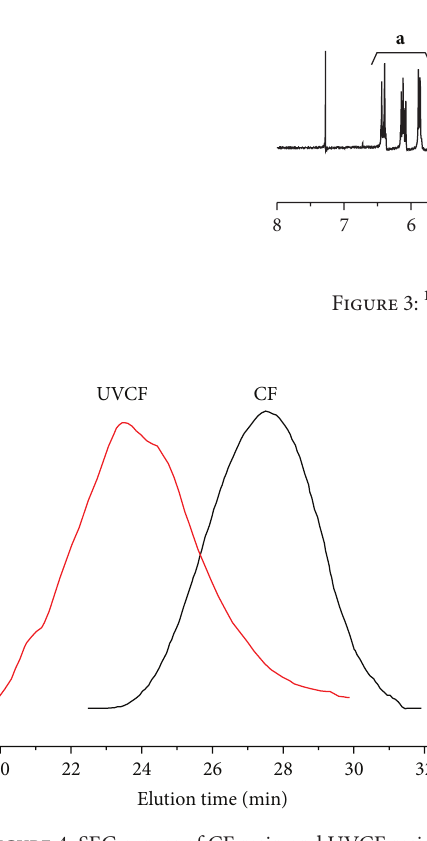
Figure 4: SEC curves of CF resin and UVCF resin.